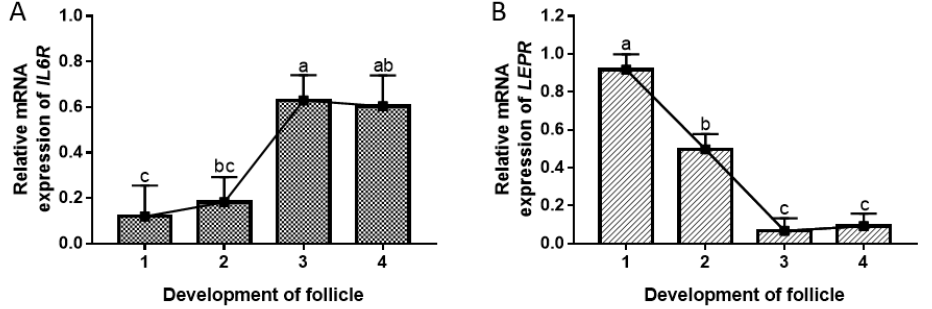
Figure 3. The relative mRNA expression level of the gene IL6R ( A ) and LEPR ( B ) in isolated granulosa. Based on the diameter (d), follicles were divided into four different development stages, including stage 1 (d ≤ 3 mm), stage 2 (3 mm < d ≤ 7 mm), stage 3 (7 mm < d ≤ 10 mm), and stage 4 (d > 10 mm). Different letters are used when the expression levels are significantly different between two stages ( p < 0.05).